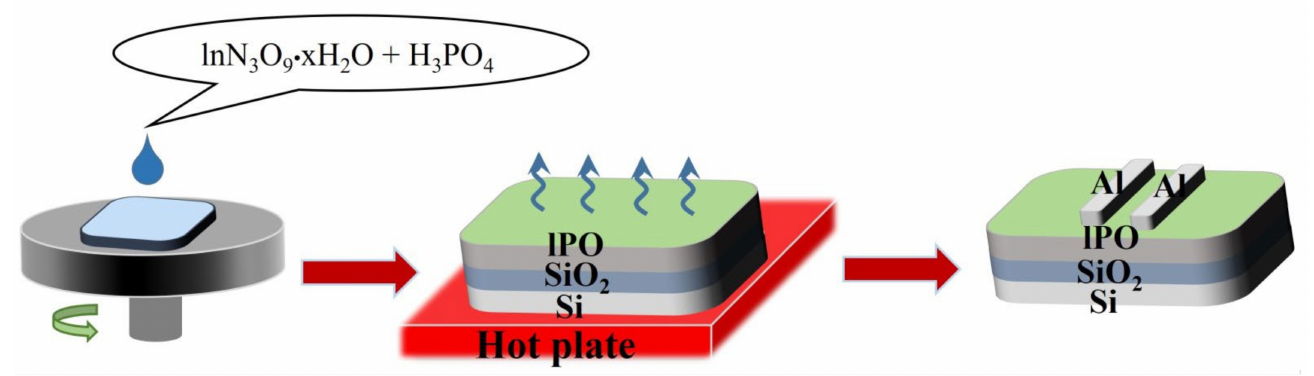
Figure 7. The IPO TFT device fabrication